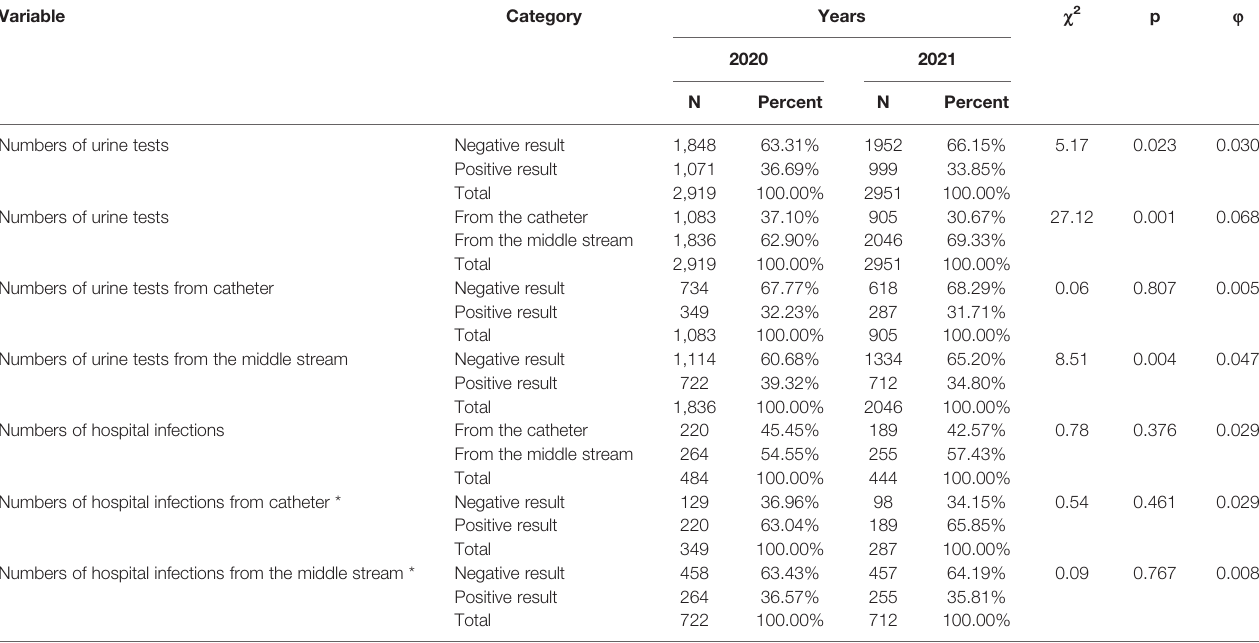
TABLE 2 | Numbers and percentage of urine tests in 2020 and 2021.